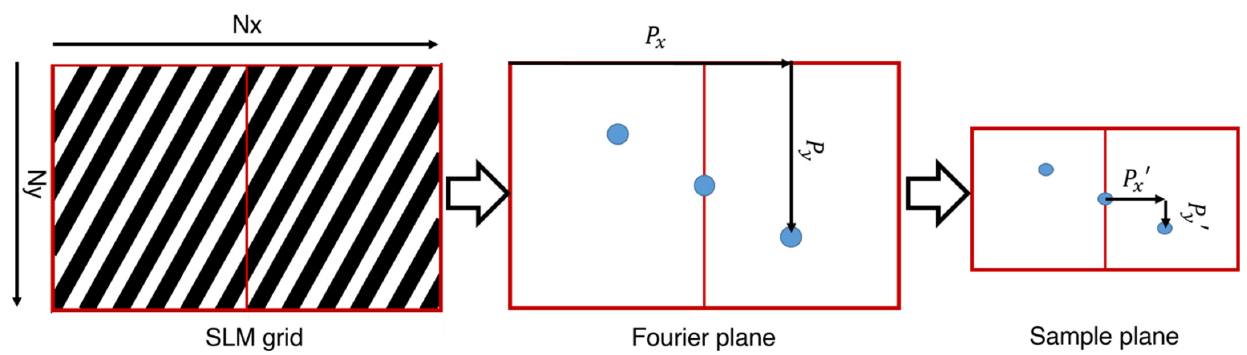
Figure 2. Schematic of the reconstruction of Fourier holograms. The hologram on the SLM is Fourier- transformed with the Fourier lens and then scaled onto the sample using the tube and objective lenses. The calculation of the hologram for the illumination of a point 𝑃 (cid:3051)(cid:3052)(cid:4593) in the sample plane is executed by first scaling this to the Fourier plane using Equations (2) and (3) followed by a Fourier